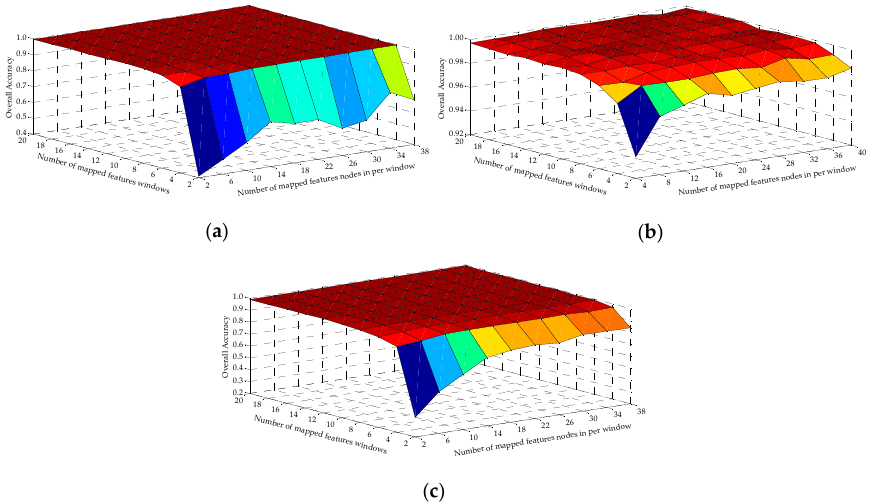
Figure 6. The relationship of the number of mapped feature windows in BLS ( M ), the number of